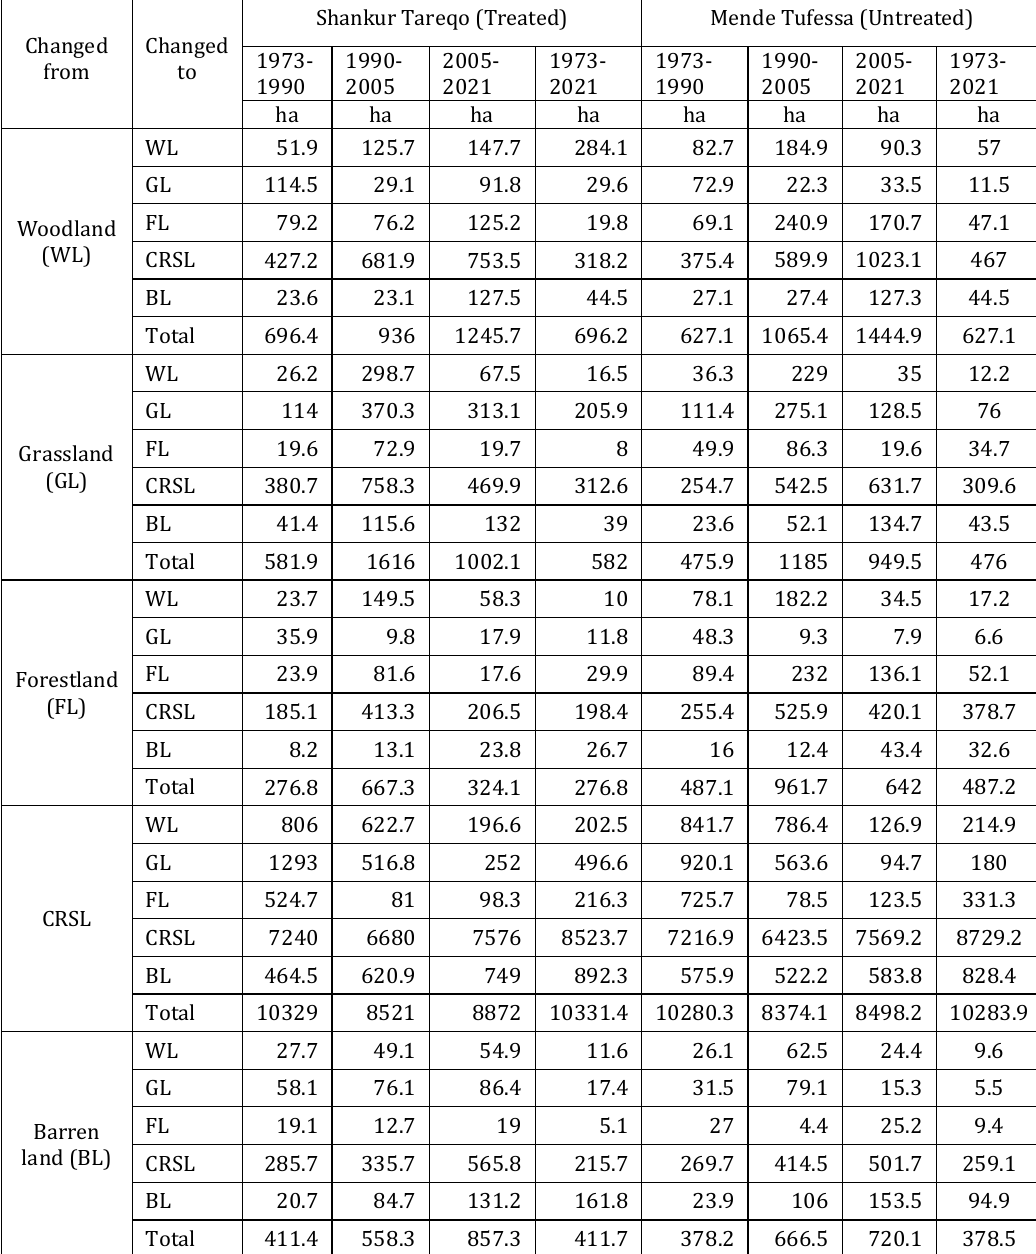
Table 3. LULC conversion matrices in different periods in each watershed (area in ha) Shankur Tareqo (Treated) Mende Tufessa (Untreated) Changed Changed from to